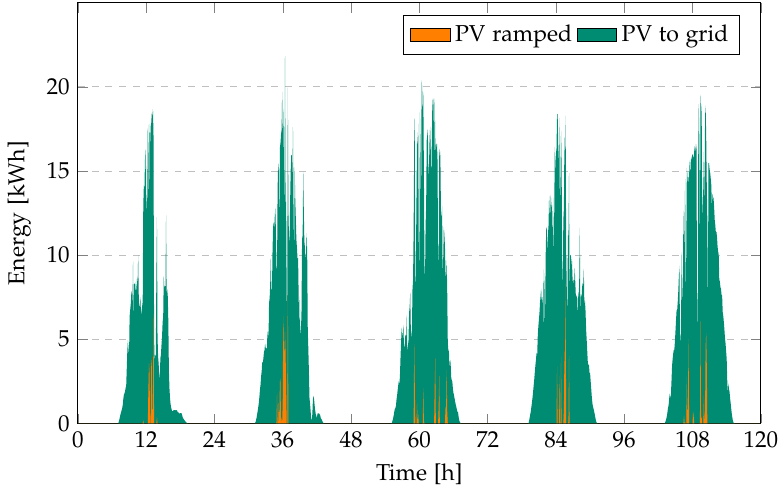
Figure 2. PV generation, PV ramped energy, and energy fed to the grid at 10% ramp requirement over a period of five days.